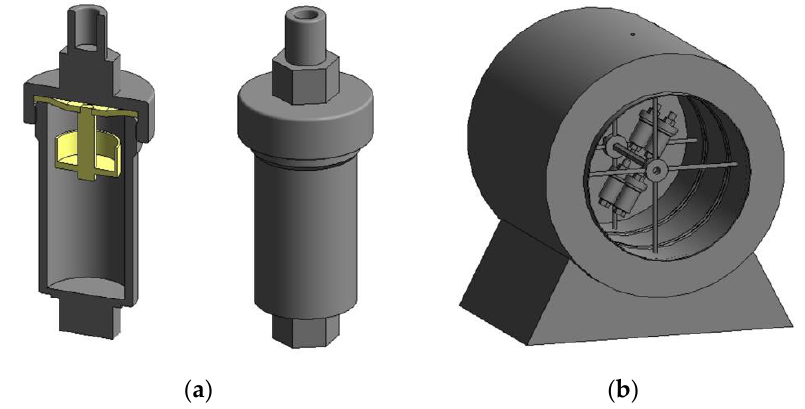
Figure 1. Experimental setup on investigation of hydrothermal treatment process: ( a ) titanium reactor and ( b ) cylindrical furnace .